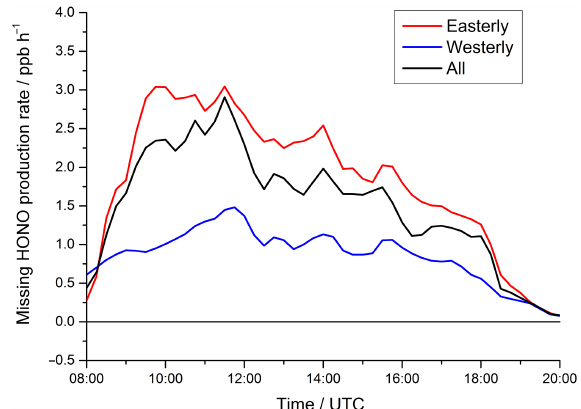
Figure 6. Average daytime diurnal profile of the “missing” HONO production rate (in ppbh − 1 ), defined as the rate of HONO pro- duction required to reproduce the measurements in the model. The black trace shows average of all data, the red trace shows the aver- age of data from easterly conditions, and the blue trace shows the average of data from westerly